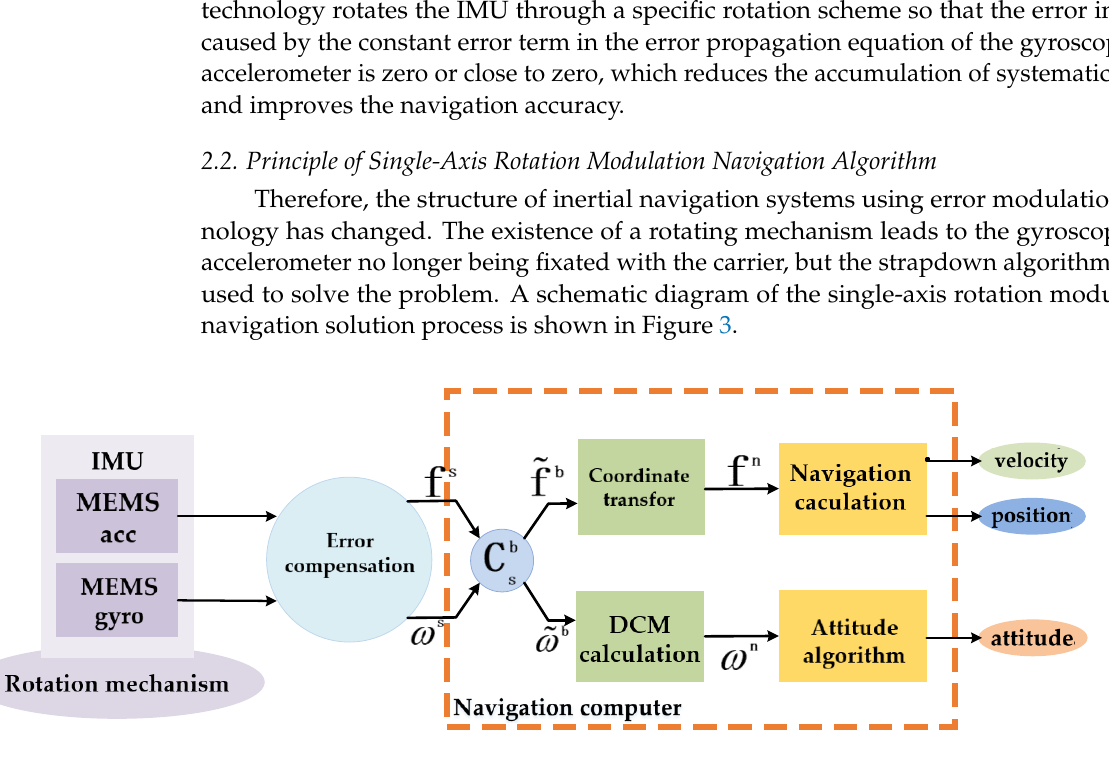
Figure 3. Schematic diagram of single-axis rotation modulation navigation solution process.